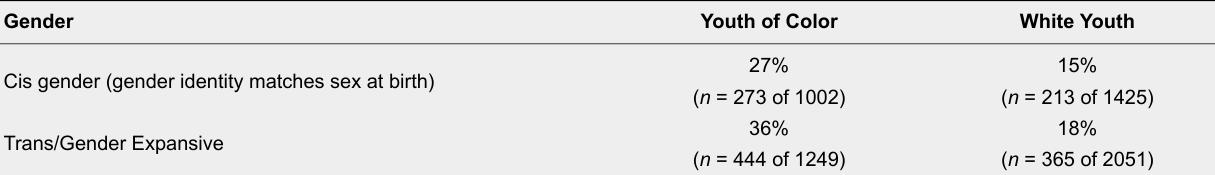
Percent who Report Negative Contact with